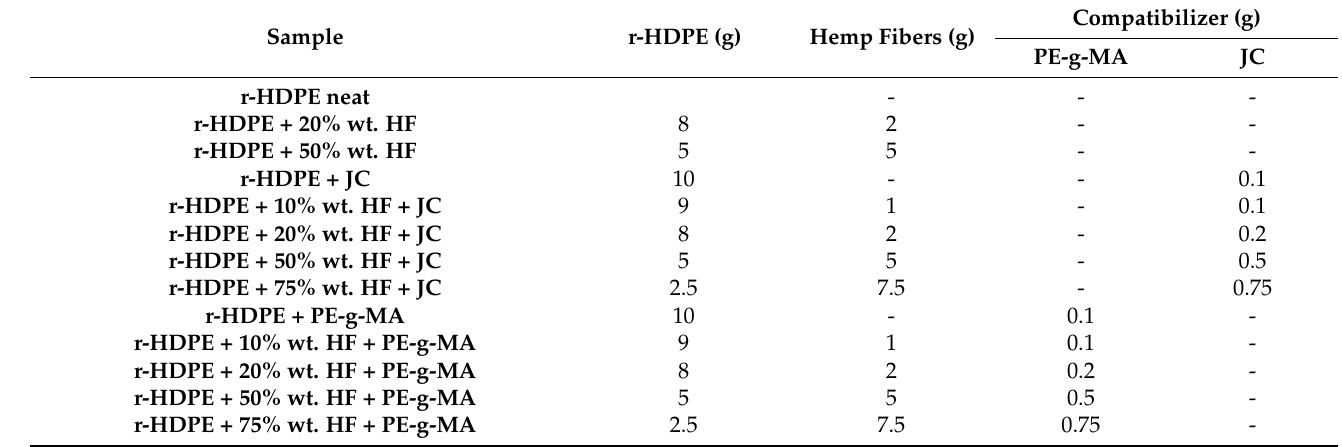
Table 1. Composition of the prepared materials detailing the amounts of recycled high-density polyethylene (r-HDPE), hemp fibers (HF), polyethylene-grafted maleic anhydride (PE-g-MA), or Joncryl ADR ® 4400 (JC) used. Sample